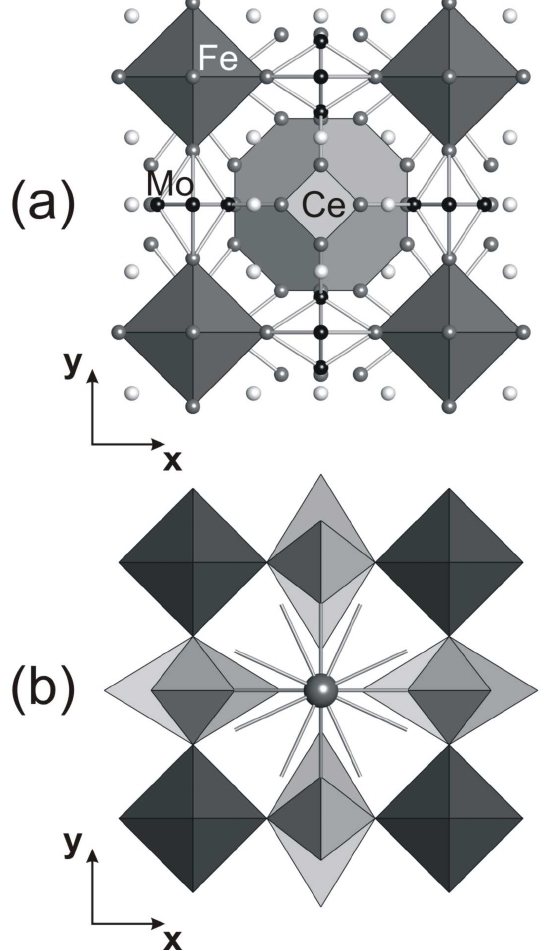
Figure 3. Crystal structure of tancaite-(Ce) in space group Pm ¯ 3 m ; (a) the Ce cation lies within the light grey polyhedron; Fe 3 + -centred octahedra are indicated in dark grey; partially occupied Mo, O, and H 2 O sites are indicated, respectively, by black, grey, and white spheres; (b) the molybdate groups are statistically distributed over four possible and mutually exclusive positions, related by the four- fold axis (light grey tetrahedra); the ligands of the Ce cation are shown.